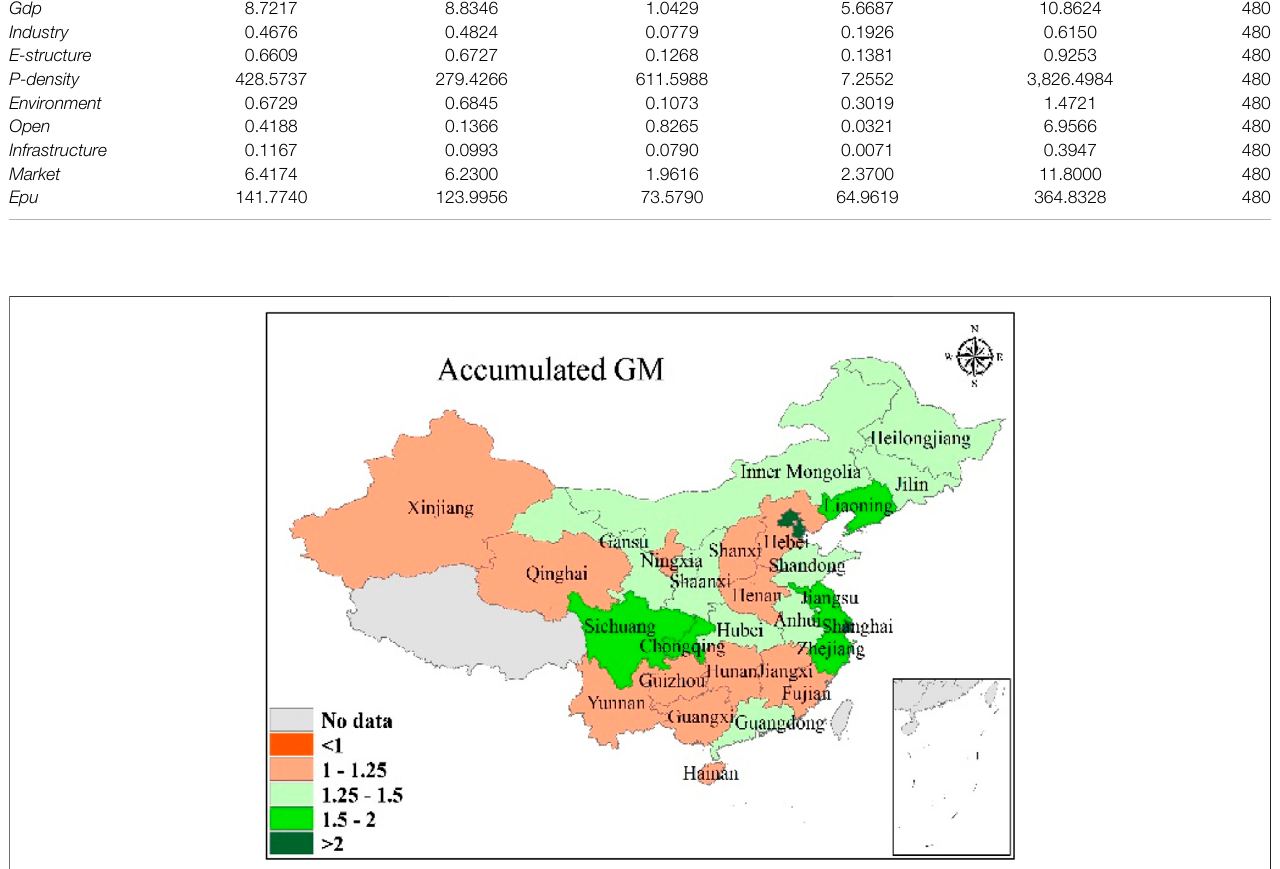
FIGURE 1 | The accumulated changes of eco-ef fi ciency in China ’ s 30 provinces from 2001 to 2016.